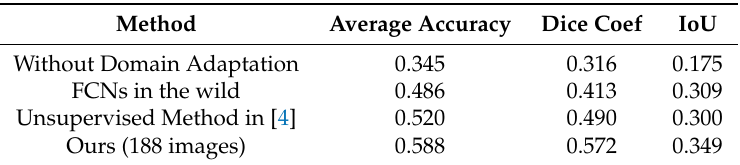
Figure 16. Segmentation IoU for different numbers of sampled from the target domain. Table 5. Segmentation Accuracy, Dice Coefficient and IoU score for different domain adaptation algorithms (Potsdam as source and Vaihingen as